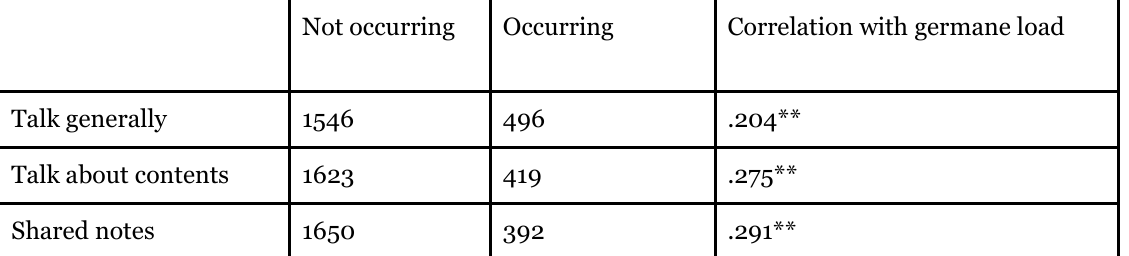
The Occurrence of the Indicators and Their Correlations With Germane Load (n = 2042) Not occurring